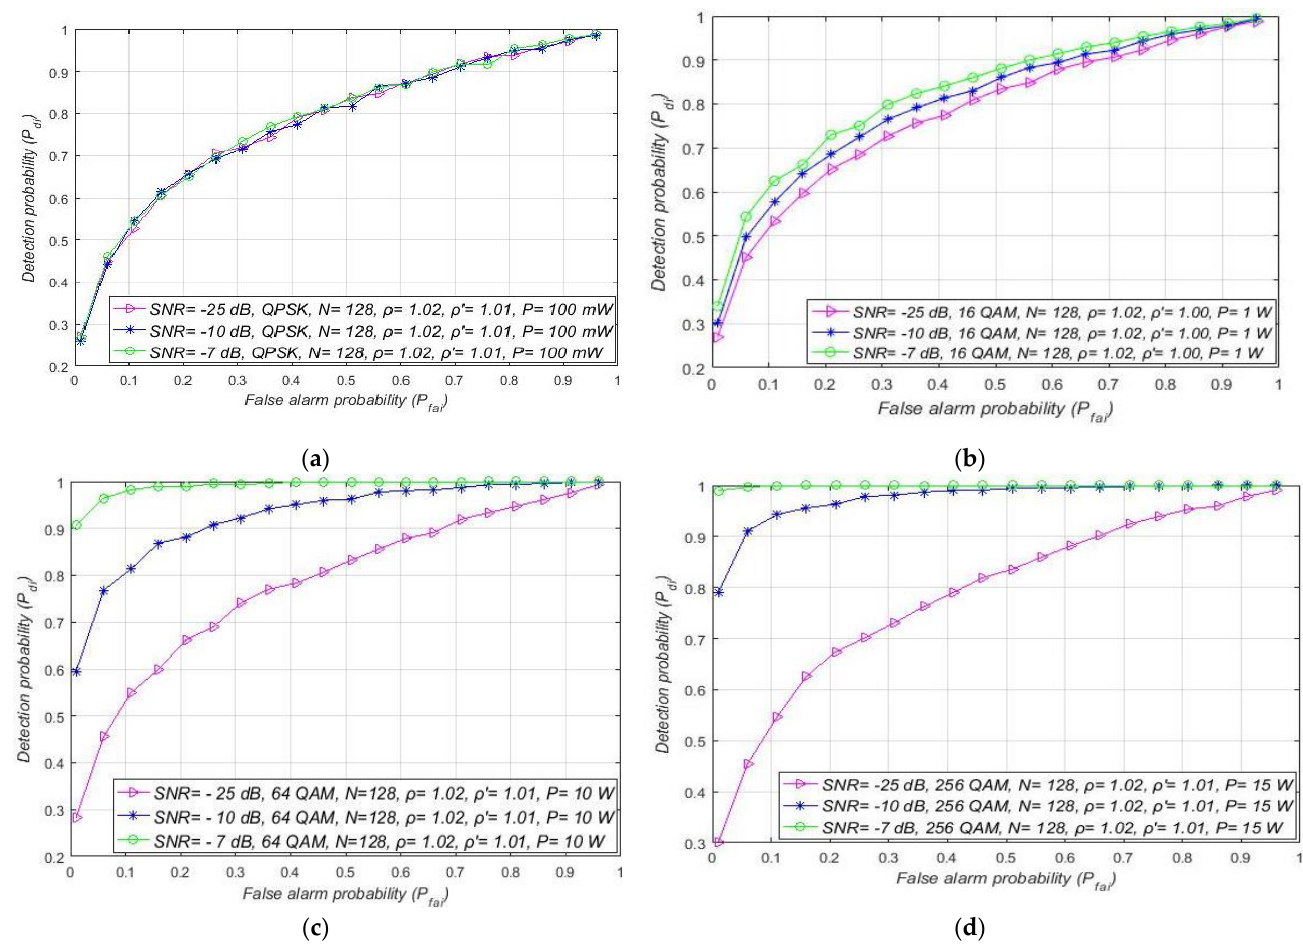
Figure 11. Interdependence between detection and false alarm probability for ED of m-PSK/m-QAM modulated signals received under different SNR levels when PU transmits at: ( a ) 0.1 W; ( b ) 1 W; ( c ) 10 W and ( d ) 15 W.